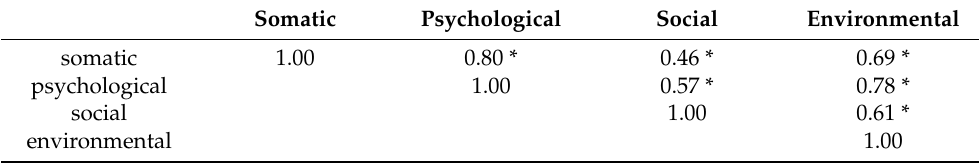
Table 5. Spearman’s correlation matrix of domain scores for the full data set before surgery.